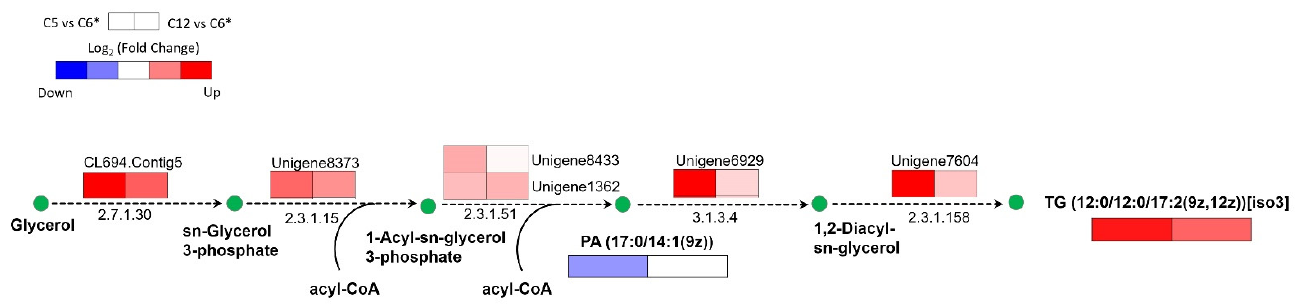
Figure 5. The subnetwork of glycerolipid metabolism in C. militaris responsible for the fungal growths on different carbon sources (C5 vs. C6 cultures and C12 vs. C6 cultures) using enhanced GSMM of C. militaris . The horizontal boxes under the metabolite name indicate the significant DAMs observed in this pathway, which are PA (17:0/14:1(9z)) and TG (12:0/12:0/17:2(9z,12z)) [iso3] represented as phosphatidic acid and triacylglycerol, respectively. A list of DAMs and DEGs involved in the glycerolipid biosynthetic pathway is listed in Supplementary File S7 (Tables S1 and S2). The asterisk (*) means the reference carbon source used for all possible pairwise comparisons.